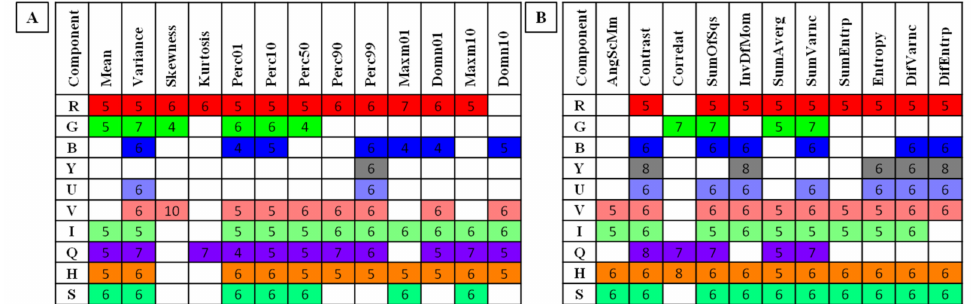
Figure 3. Features of ( A ) Histogram Statistics and ( B ) Gray Level Co-occurrence Matrix for each examined color component found to be significantly different between non-pregnant and pregnant groups from a given (numbered) month as compared to the end of pregnancy. R—Red component in the RGB color model; G—Green component in the RGB color model; B—Blue component in the RGB color model; Y—Brightness component in the YUV/YIQ/HSB color models; U—U-component in the YUV color model; V—V-component in the YUV color model; I—I-component in the YIQ color model; Q—Q-component in the YIQ color model; H—Hue component in the HSB color model; S—Saturation component in the HSB color model. Skewness—skewness coefficient; Perc01, Perc10, Perc50, Perc90, Perc99—percentiles; Domn01, Domn10—dominants; Maxm01, Maxm10—maximum